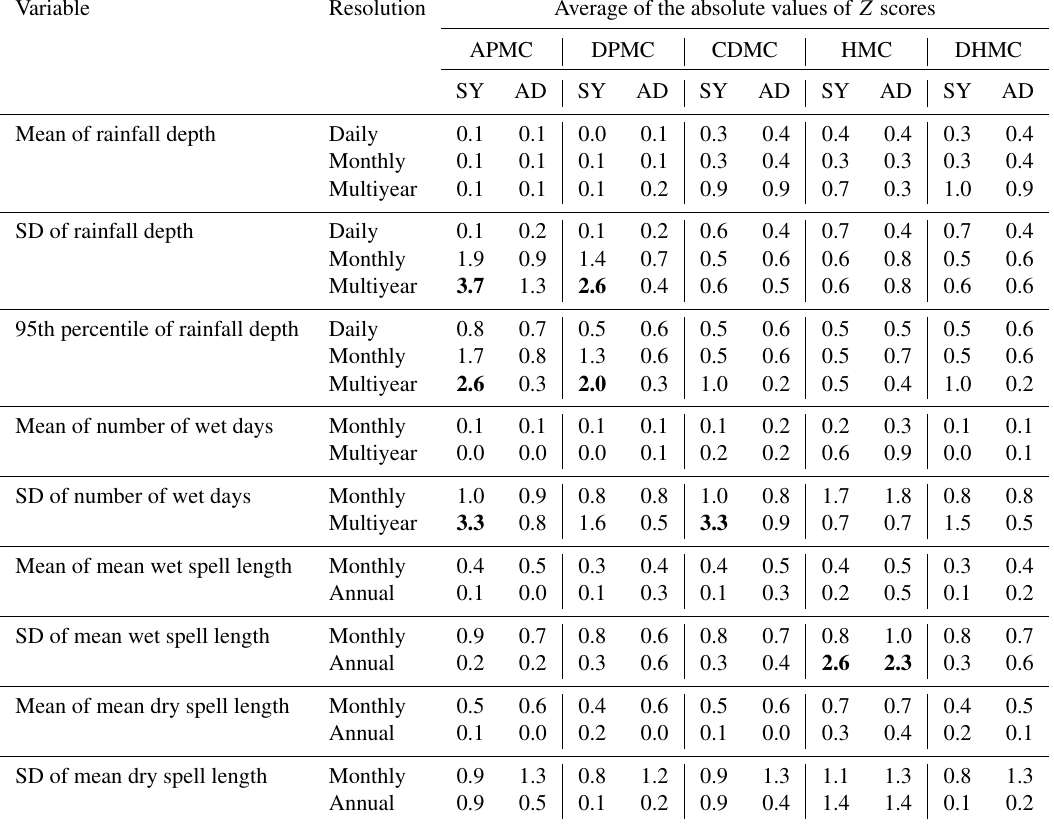
Table 2. Average of the absolute values of Z scores (average of the Z scores for all 12 months at daily and monthly resolutions, and average of the Z scores for 1 to 10 years at multiyear resolution) for Sydney (SY) and Adelaide (AD). The averaged Z scores greater than 2 are shown in